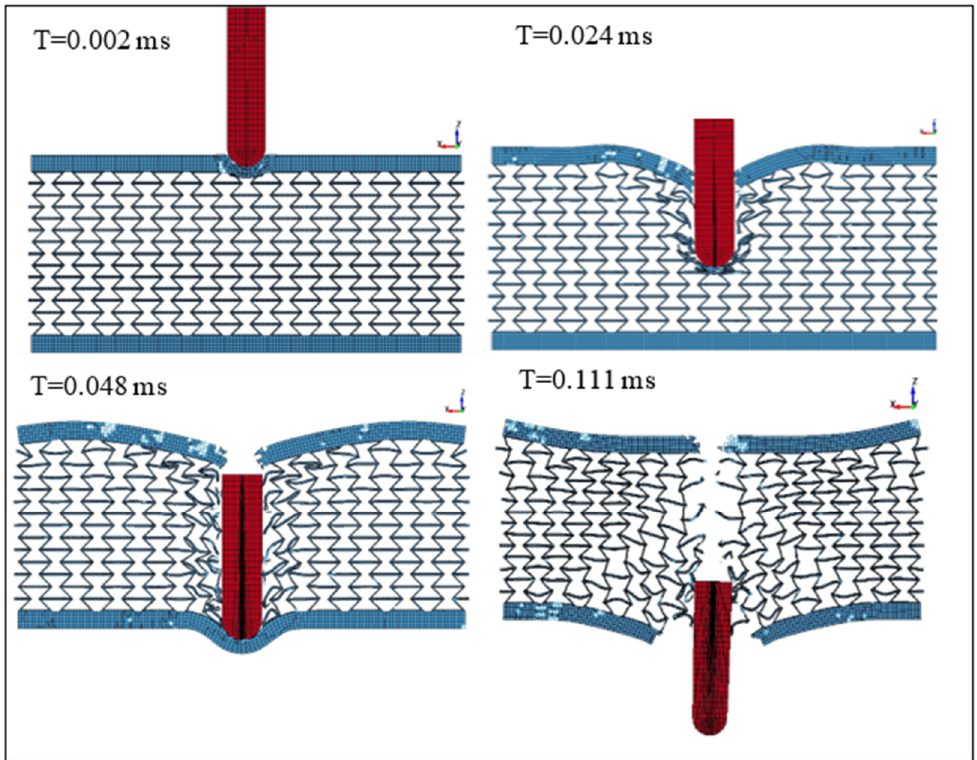
Figure 15. Structure deformation at different timings, Vi = 900 m/s.